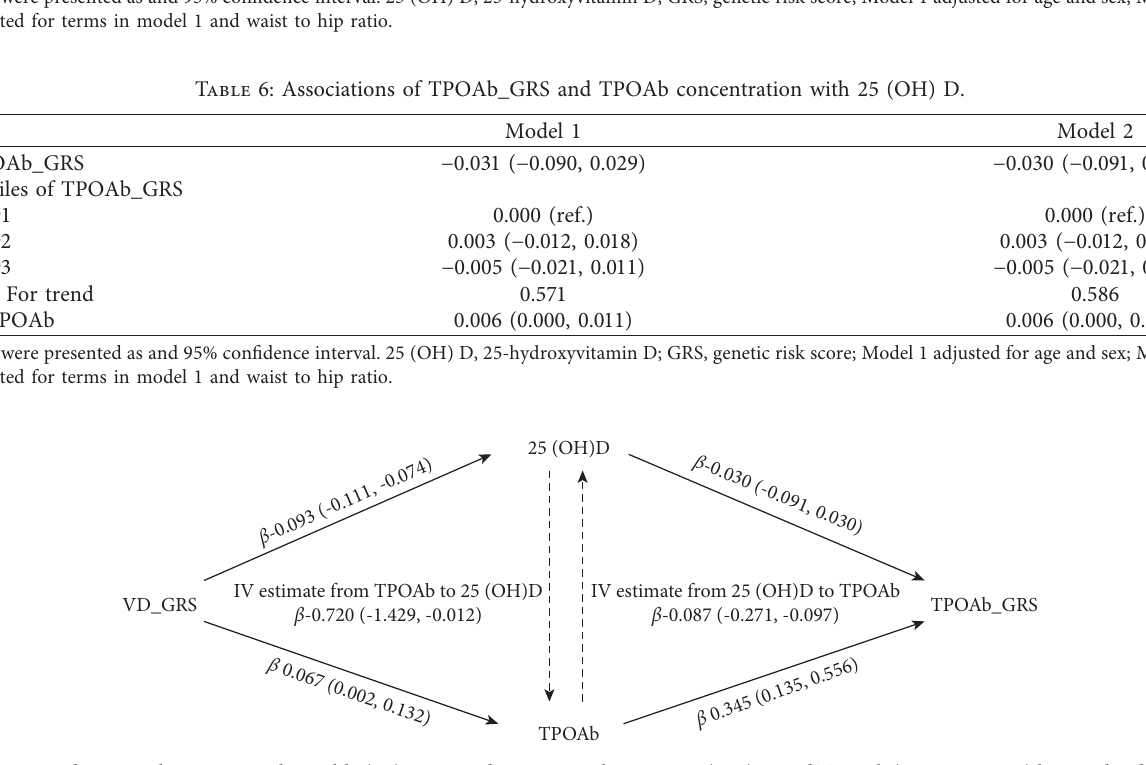
Figure 2: Bidirectional instrumental variable (IV) estimated association between 25 (OH) D and TPOAb (concentration) by weighted GRSs. Data were adjusted for age, sex, waist to hip ratio.